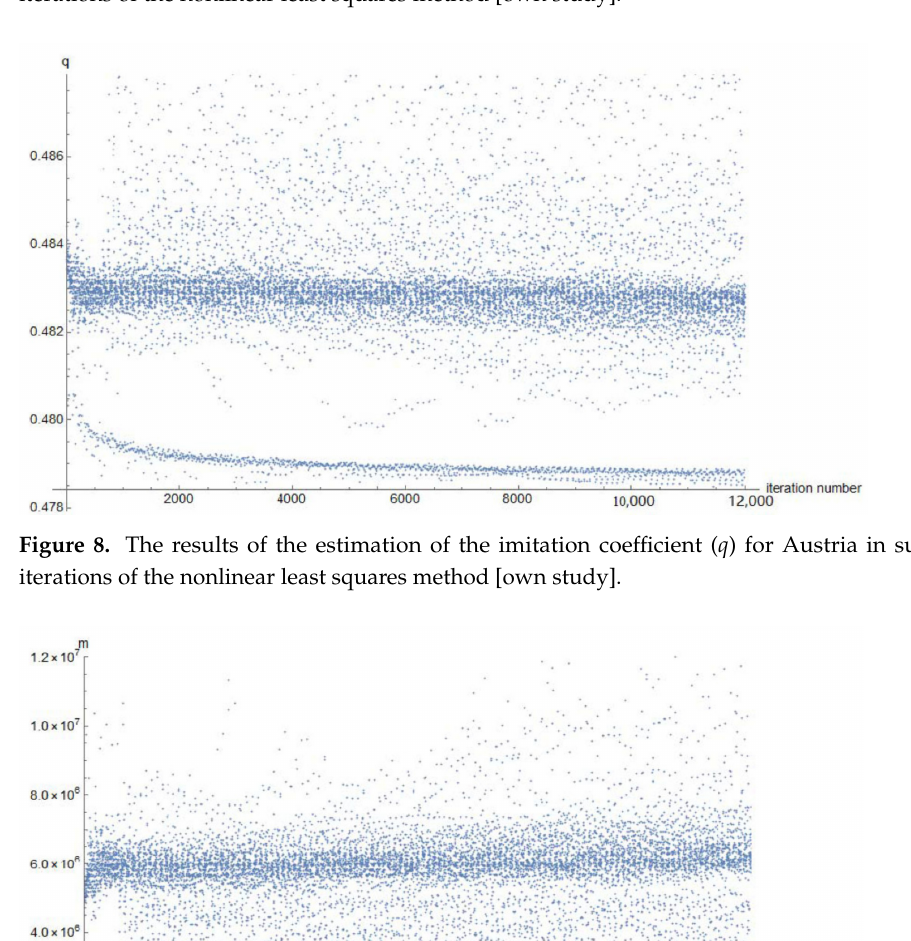
Figure 7. The results of the estimation of the innovation coefficient ( p ) for Austria in successive iterations of the nonlinear least squares method [own study].